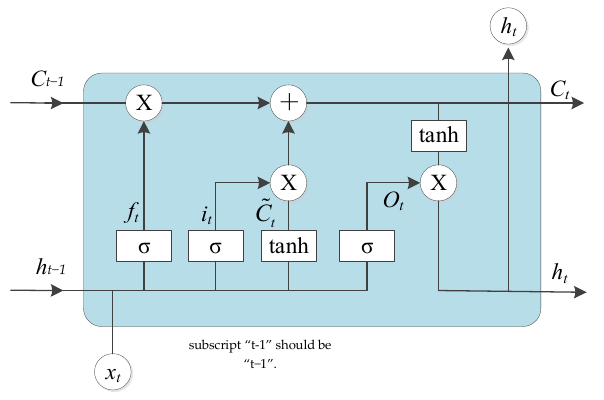
Figure 1. LSTM memory unit.